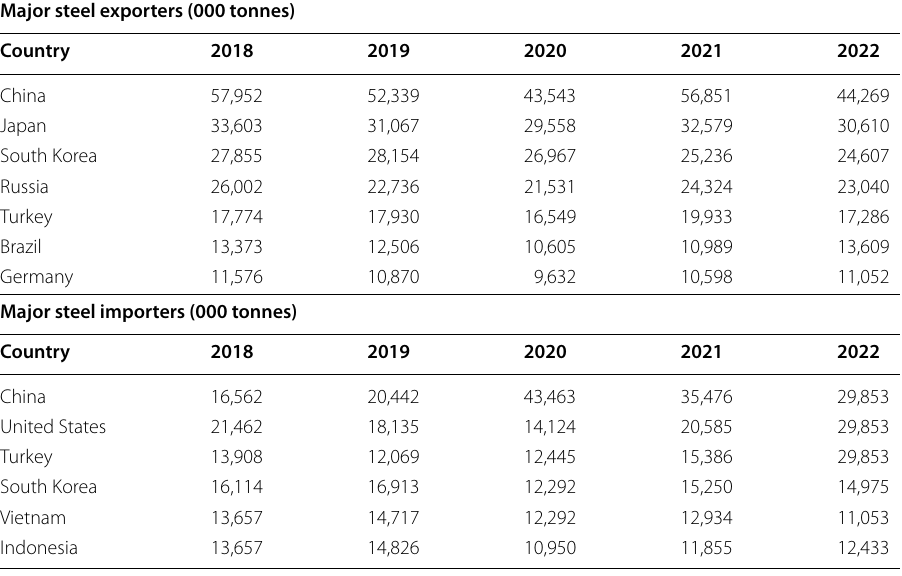
Table 3 The global movement of steel products (Drewry. 2022) Major steel exporters (000